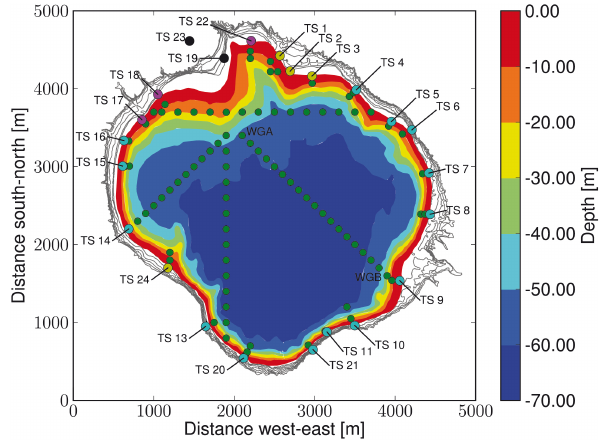
Fig. 2. Bathymetry of Karymskoye lake, and topographic contours of the lake shore each 5 m. Markers indicate location of runup measurement sites (cyan, yellow, magenta, black) and of 91 numerical wave gauges (green).